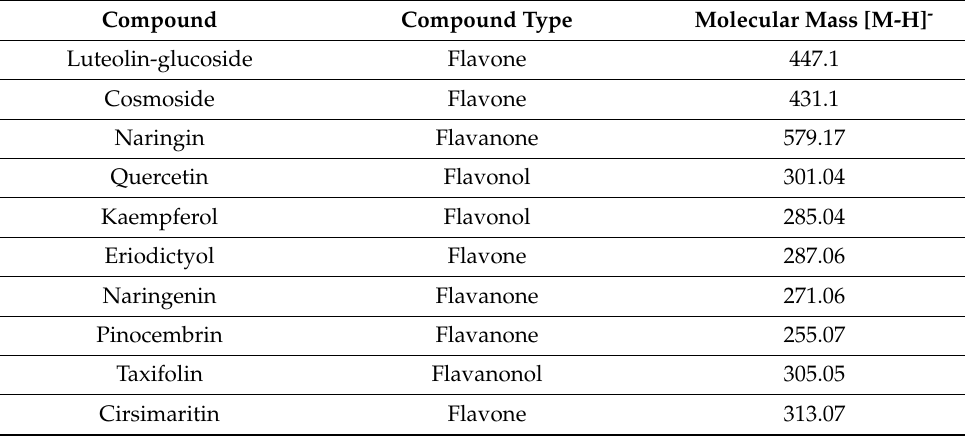
Table 2. Flavonoids from the ethanolic extract of L. graveolens characterized by UPLC-MS.